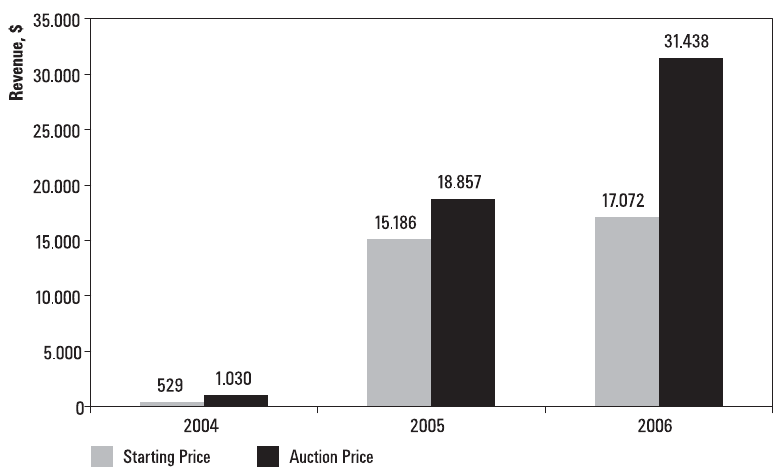
Figure 2. Sales revenues: expected at starting prices and actual from auctions,